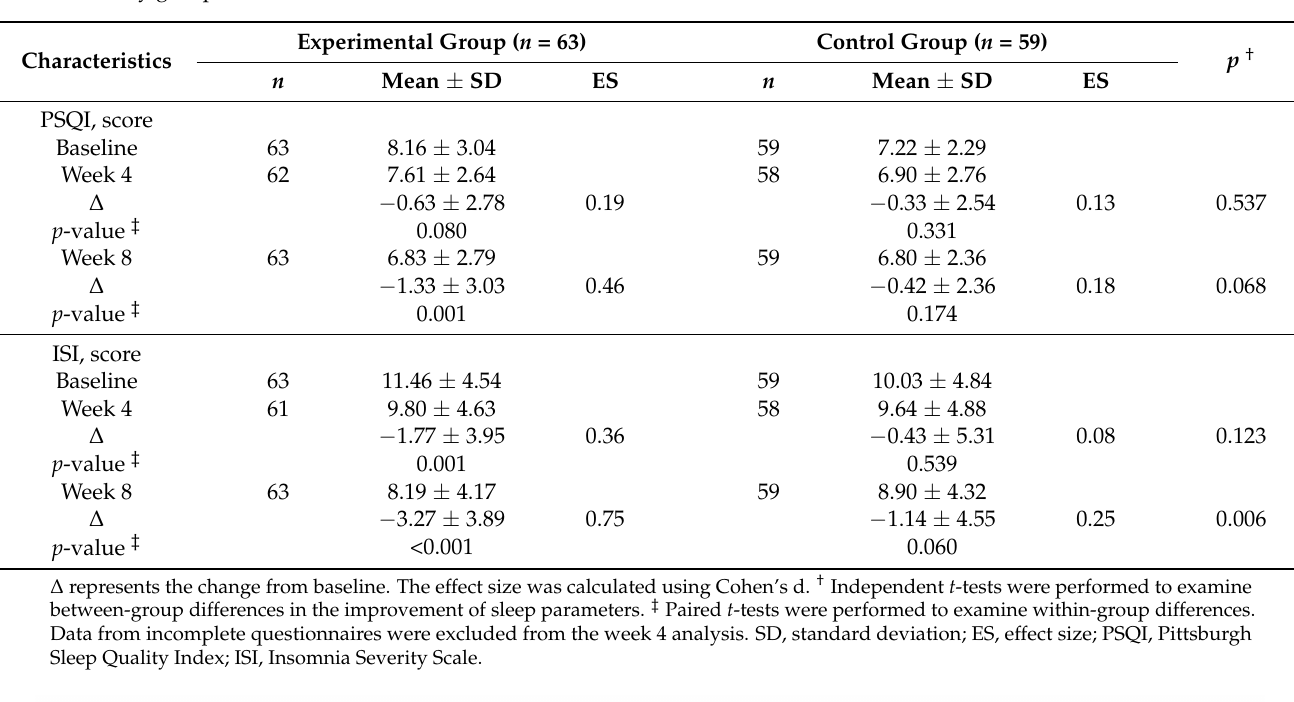
Table 3. Comparison of the changes in sleep parameters from baseline to four and eight weeks of intervention between the two study groups.